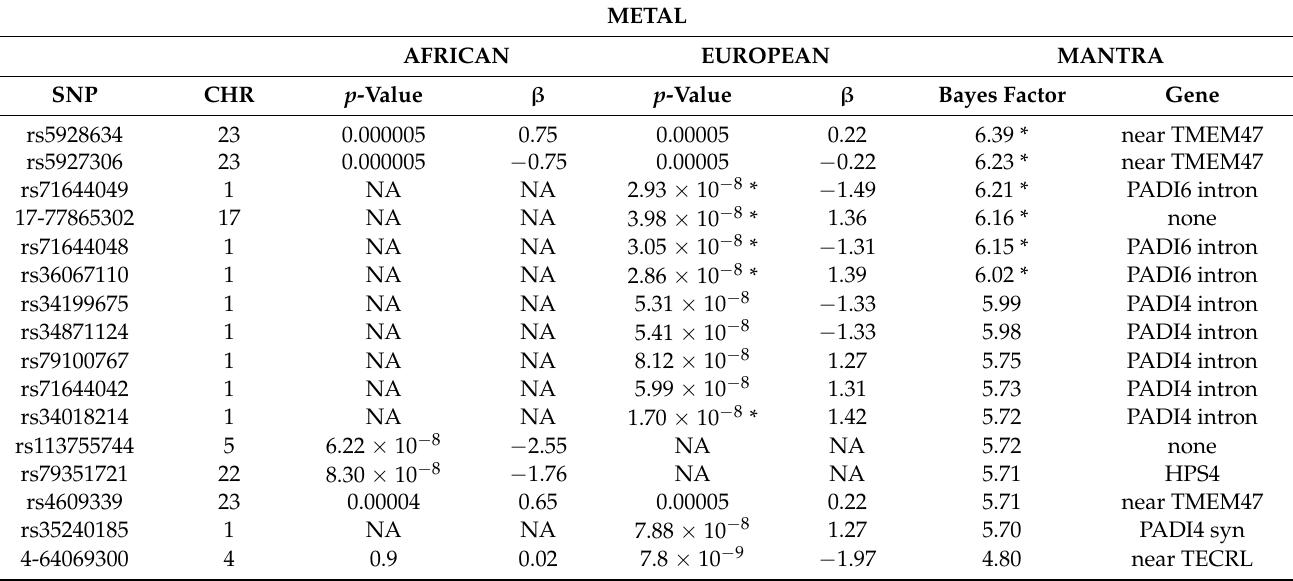
Table 2. METAL and MANTRA analyses for generalized